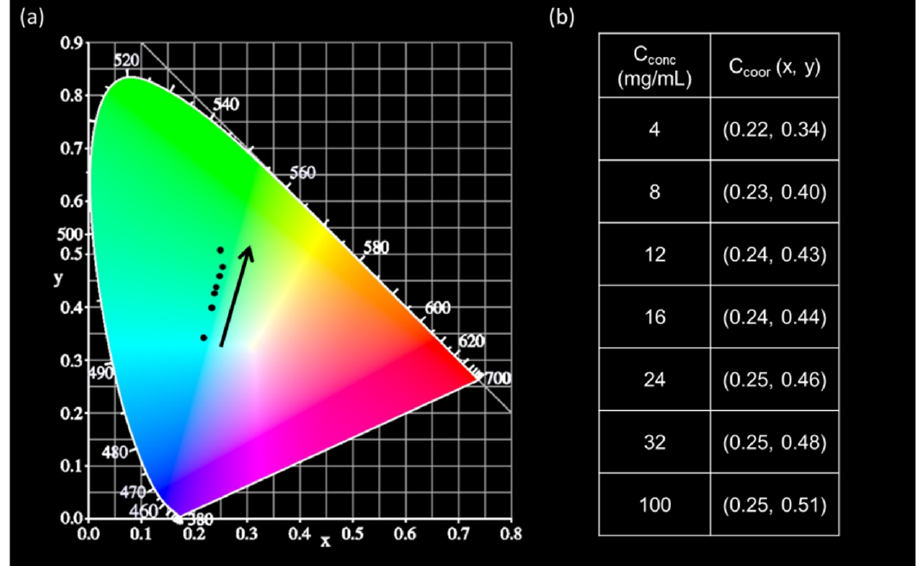
Figure 5. ( a ) The corresponding CIE coordinates of PPMU at different concentrations (4 mg/mL, 8 mg/mL, 12 mg/mL, 16 mg/mL, 24 mg/mL, 32 mg/mL, 100 mg/mL) in CHCl 3 ; ( b ) Table of the corresponding relationship between PPMU concentrations (C conc ) and CIE coordinates (C coor ).